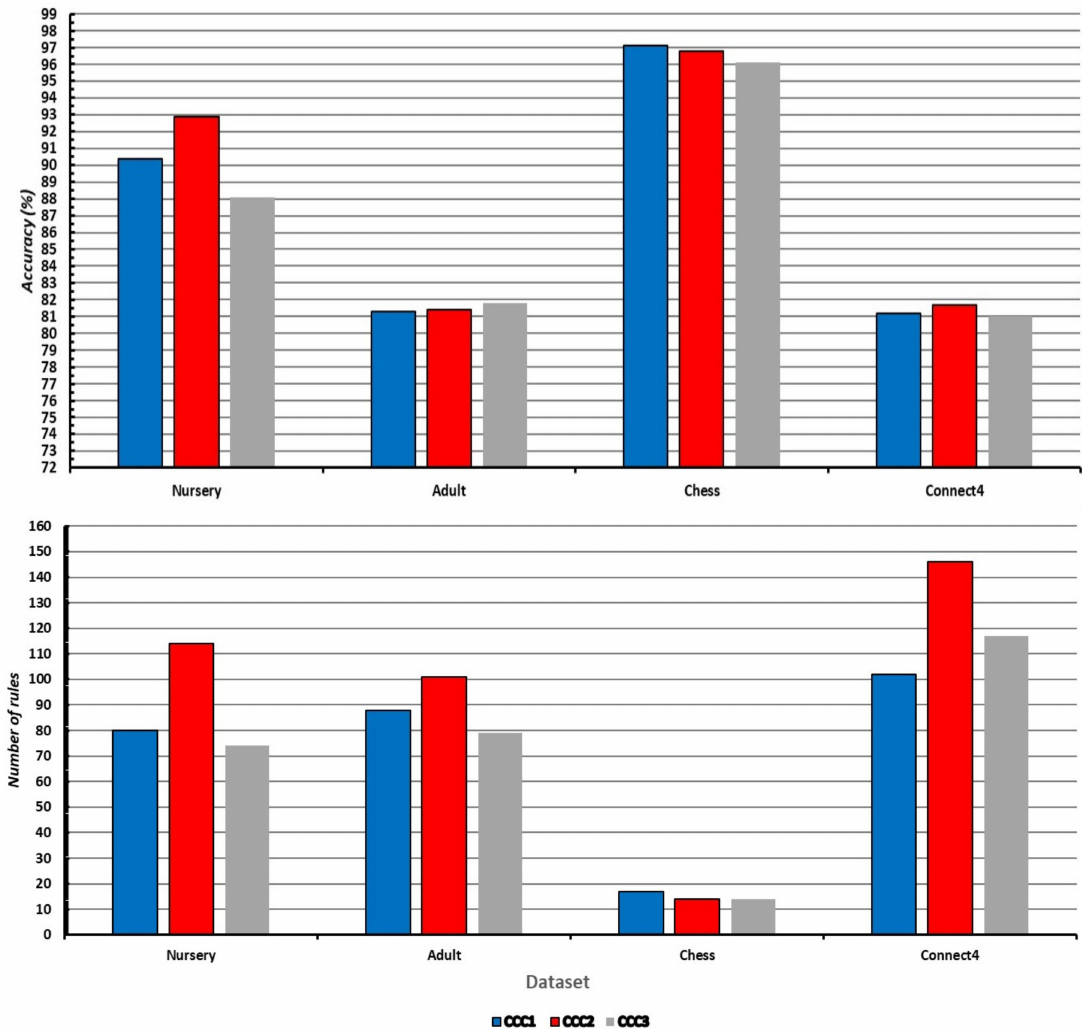
Figure 4. Comparison of our methods of size for “bigger”